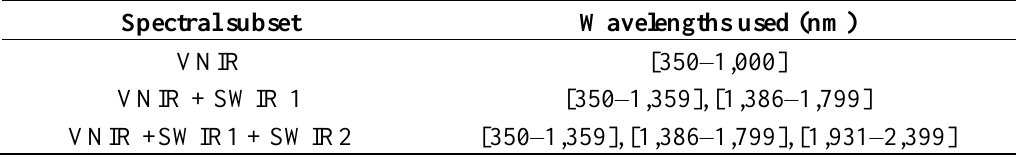
Table 3. Wavelengths which define the three spectral subsets considered in this